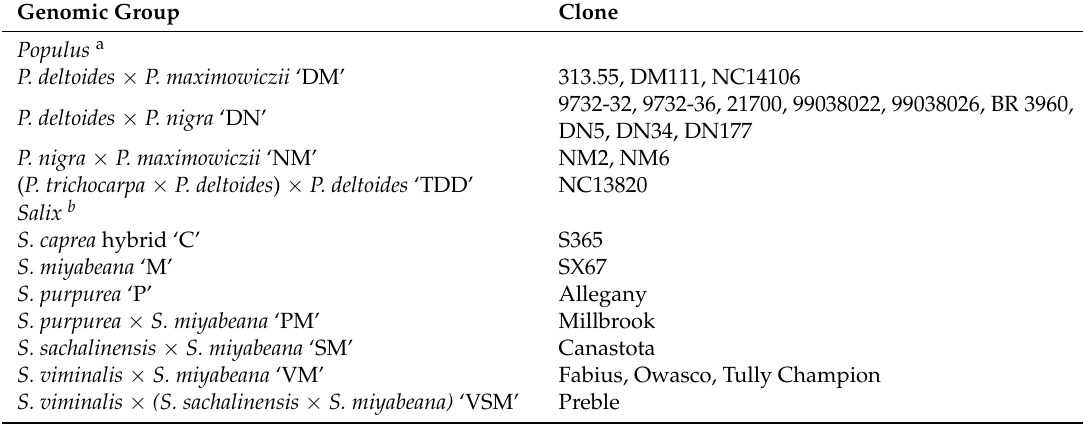
Table 2. Populus and Salix genomic groups and clones tested in phyto-recurrent selection cycle 3 in a study assessing how root–shoot allocations contribute to biomass production and overall health when grown for 65 days in soils from five landfills in eastern Wisconsin,